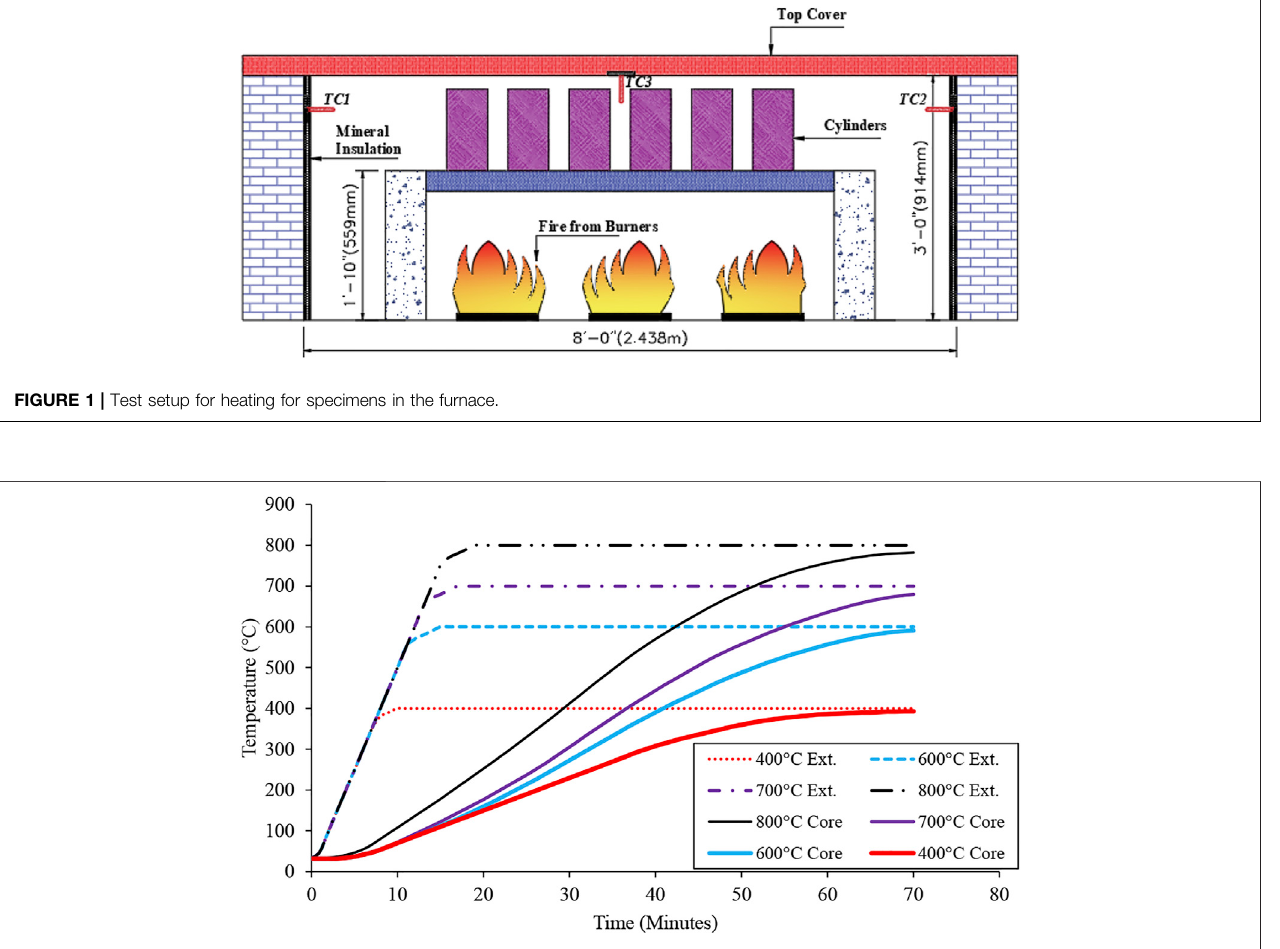
(ref: Figure 5A ). The components were mixed for 3 min until a uniform greyish color was obtained and consistency became smooth.